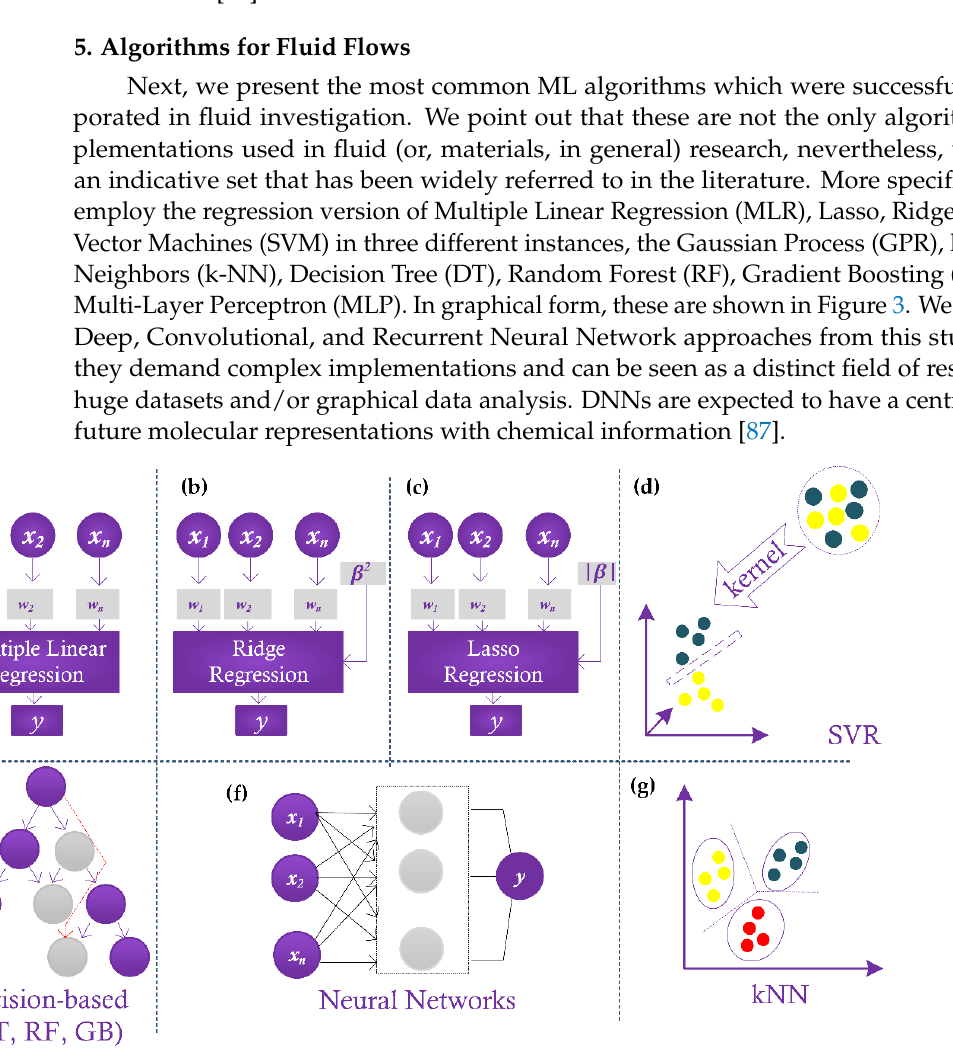
Figure 3. ML algorithms incorporated in fluid research—indicative list. ( a ) Multiple Linear Regres- sion, ( b ) Ridge Regression, ( c ) Lasso regression, ( d ) Support Vector Regression, ( e ) Decision tree. Random Forest and Gradient Boosting are also based on this tree-model, ( f ) Neural Network for the Multi-Layer Perceptron model and ( g ) the k-Nearest Neighbors idea, where neighboring points are considered to belong to the same